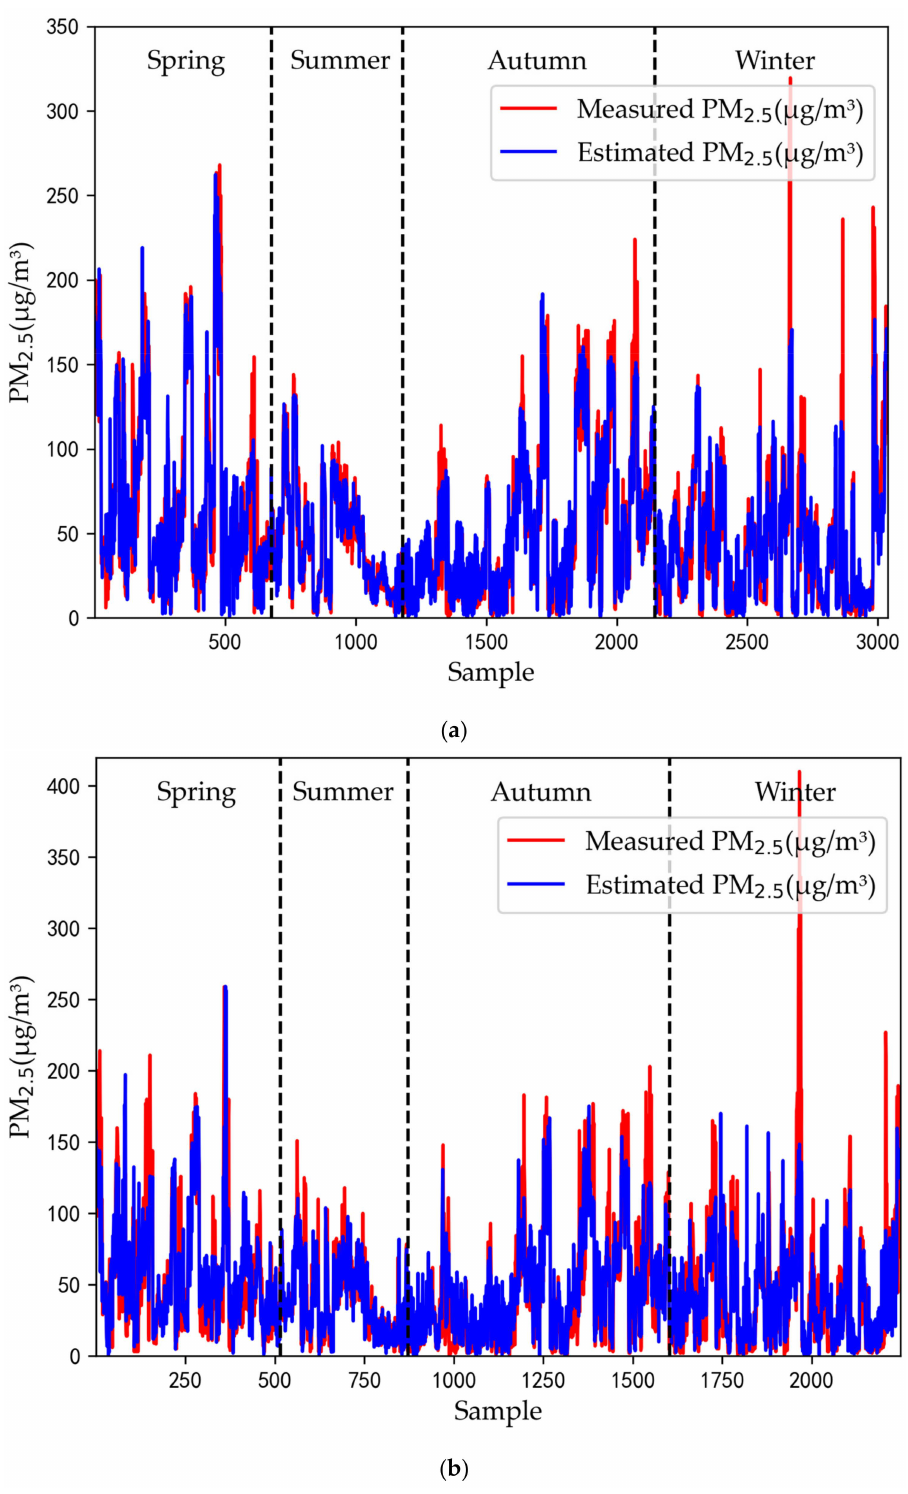
Figure 9. Comparison of measured PM 2.5 and estimated PM 2.5 based on VIIRS/DNB data in the sequences of validation set: ( a ) is in the urban area. ( b ) is in the